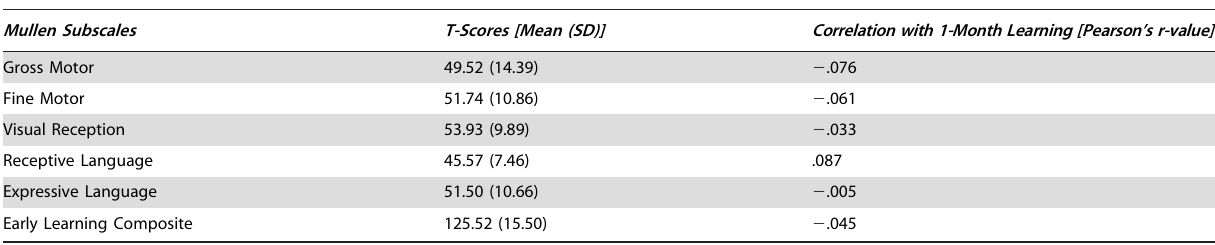
Table 2. Mullen Scales of Early Learning